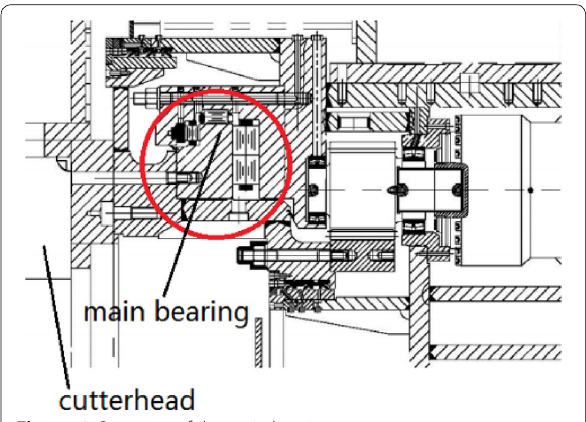
Figure 6 Structure of the main